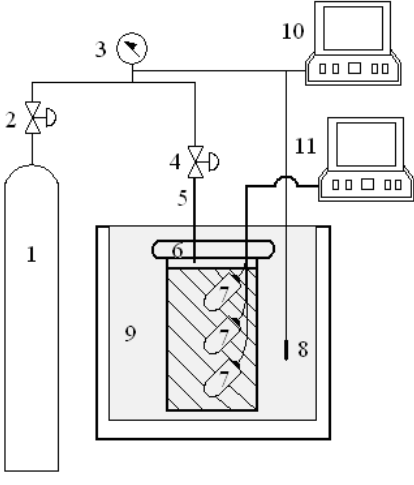
Figure 1. Schematic diagram of the experimental apparatus [27]. Parts: 1. gas cylinder; 2. gas valve; 3. pressure gauge; 4. gas valve; 5. gas line; 6. reaction cell, height = 19.5 cm, diameter = 10.0 cm; 7. pF-meter sensors, length = 7 cm, diameter = 2 cm; 8. coolant temperature sensor; 9. low-temperature batch; 10. data-logging system of pressure value and coolant temperature; 11. data-logging system of pF value and temperature inside